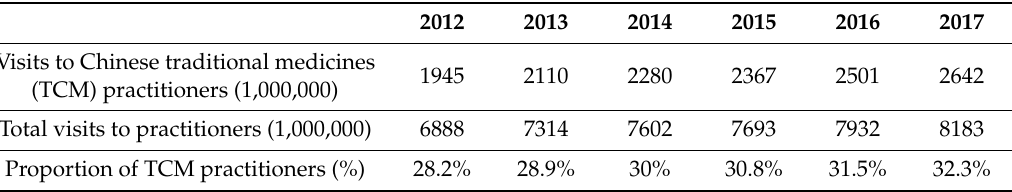
Table A1. Number of visits to medical practitioners in China,